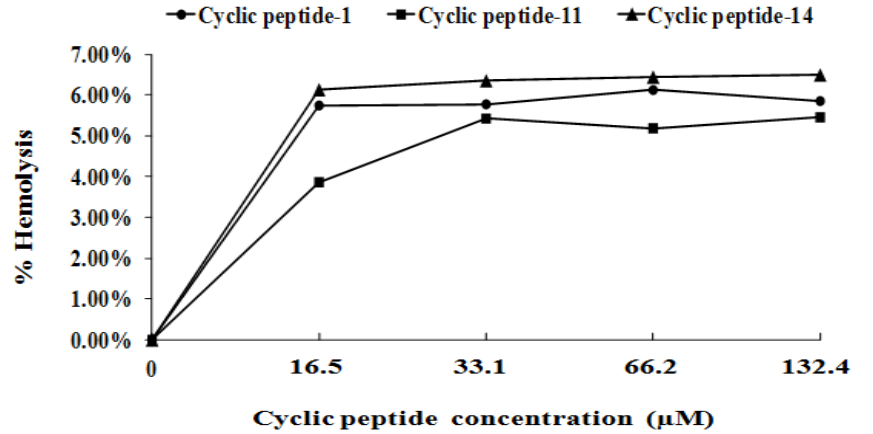
Figure 6. Percentage of hemolysis of rabbit blood cells at various cyclic peptide concentrations. Cell survival after 48 h of incubation with different concentrations of cyclic peptides was evaluated by an MTT assay. The toxicity of cyclic peptide-1, -11, and -14 toward human liver L02 cells is shown in Figure 7. As negative controls, 5‰ DMSO was